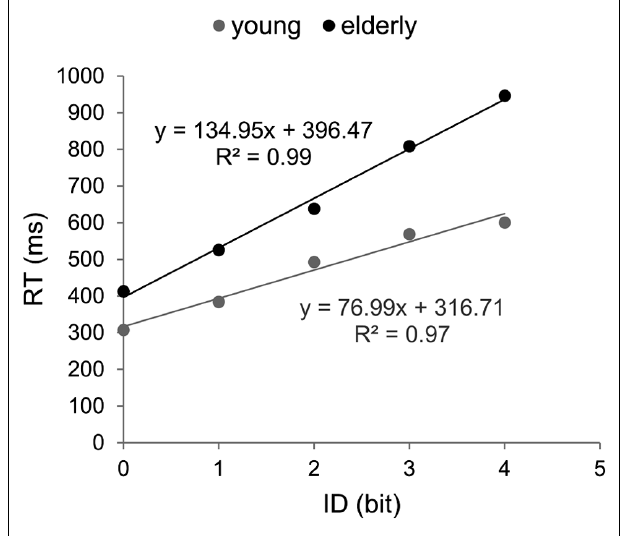
FIGURE 1 | Efficiency functions for movement time in Fitts’ task. Young participants’ data and linear regression estimates are presented in gray and those of older participants in black. Table 1 | Mean and standard deviation values of response times and ANOVA results.